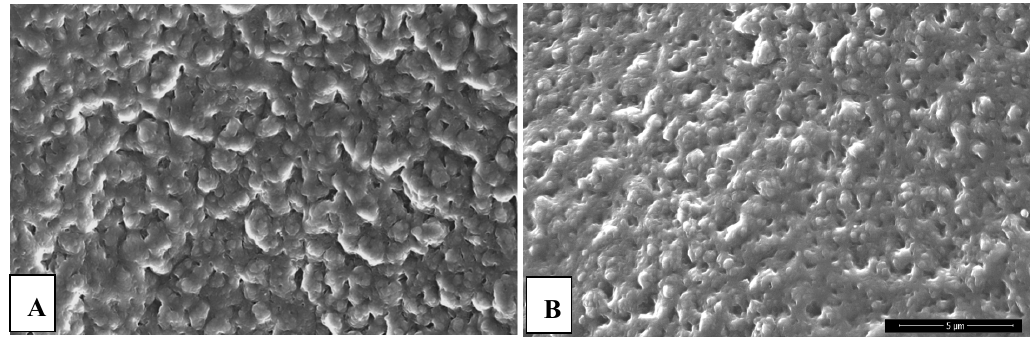
Figure 7. SEM microphotographs of chitosan hydrogels: ( A ) without additive; ( B ) modified with 5 mL silver nanoparticles.